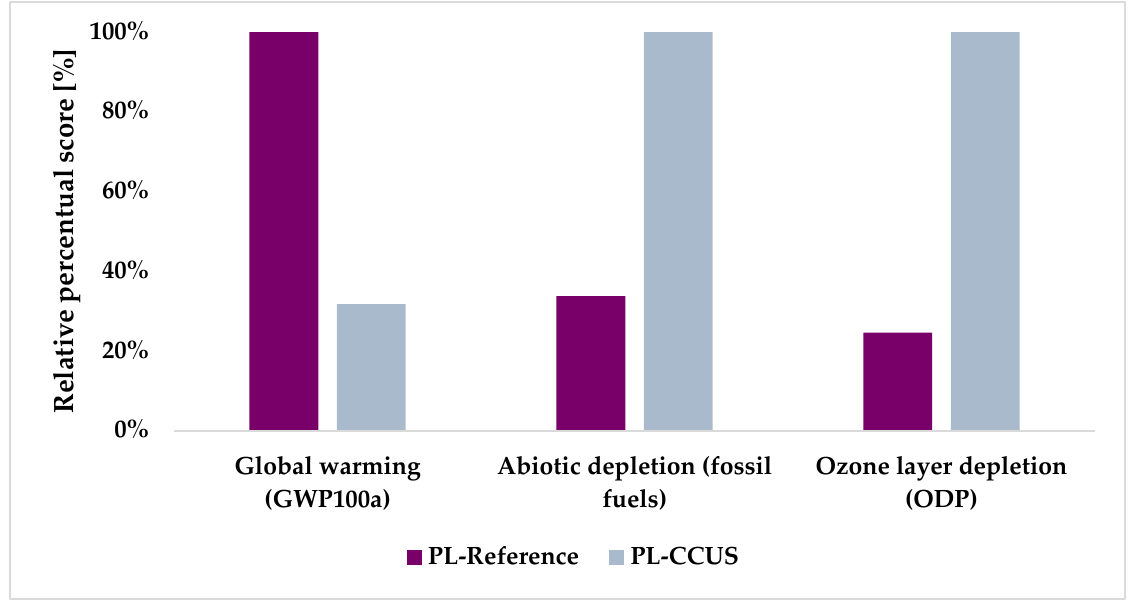
Figure 6. Impact category scores for the Polish case study in the CCUS scenario.